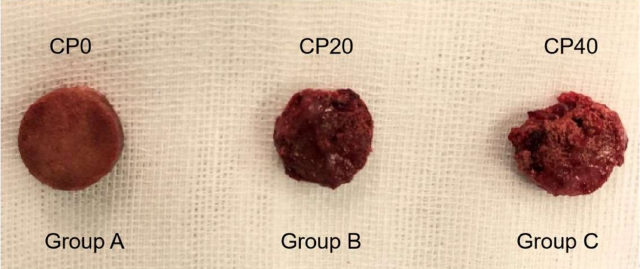
Figure 7. The density of fibrous vascular growth on the surface of 3 groups of implants at 4 weeks with CP0 (Group A), CP20 (Group B), and CP40 (Group